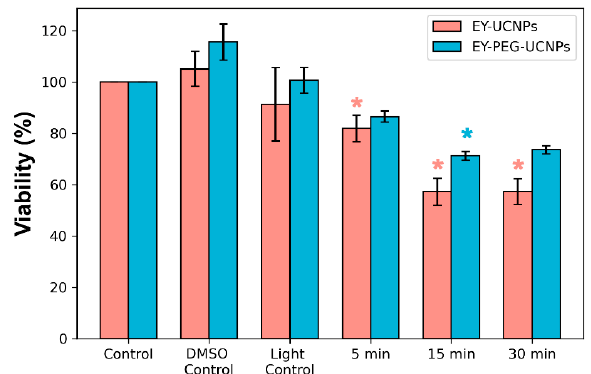
Figure 6. Viability of HeLa cells with EY-UCNPs and EY-PEG-UCNPs after 5, 15, and 30 min of irradiation with a NIR lamp. Both control experiments for DMSO and IR irradiation in the absence of UCNPs are also included. A statistical analysis was performed using a two-sample student’s t -test, and stars indicate significant differences between the control and the analyzed sample with p values < 0.05. (*) indicates 0.01 < p <